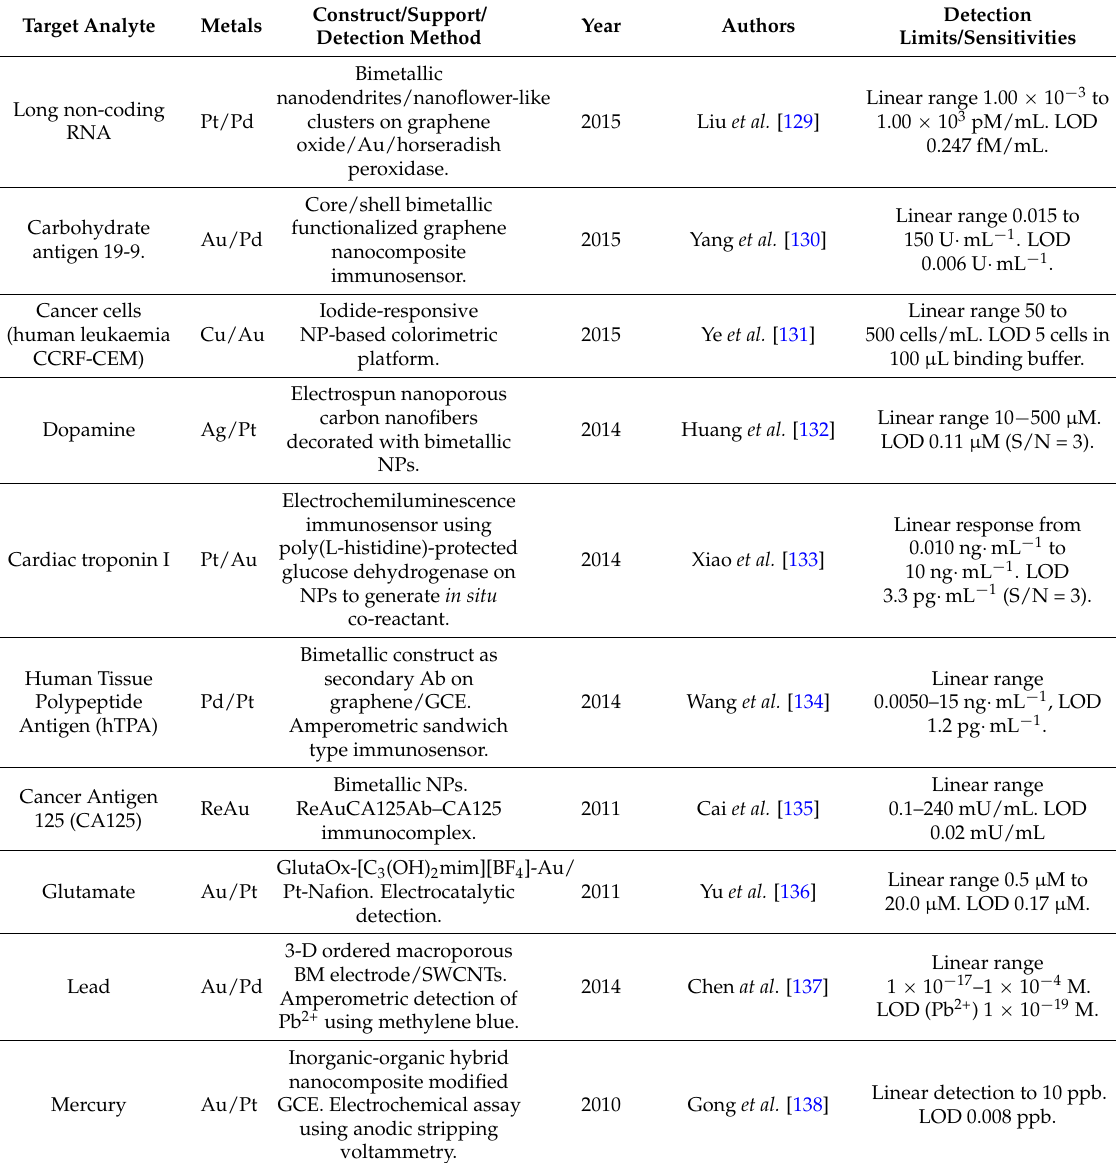
Table 7. Bimetallic constructs used for sensing miscellaneous